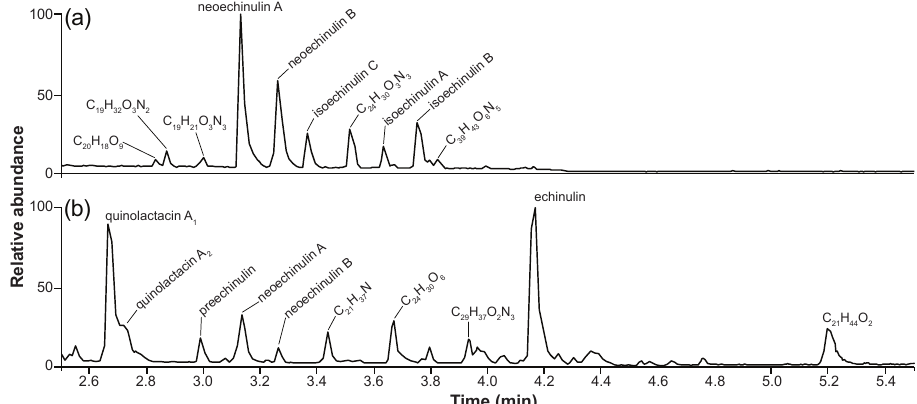
Figure 3. Base peak chromatograms observed in positive ionization mode. a Aspergillus mallochii (DAOMC 146054 = KAS 7618) b Aspergillus megasporus (DAOMC 250799 = KAS 6176). Both species show some production of echinulin class of alkaloids to varying amounts. Quinolactacin A1, A2 and B were not detected in A. mallochii